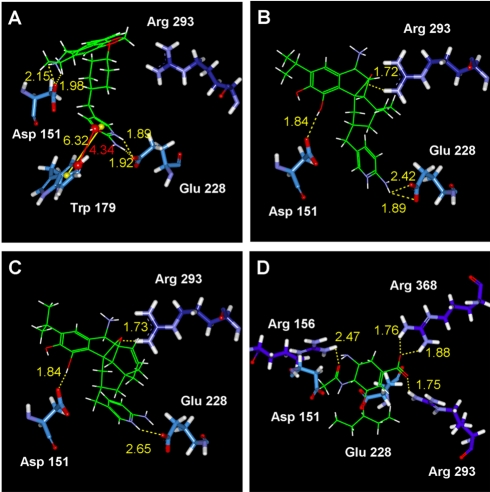
Docking pose of TCM candidates and Tamiflu® in N1.(A) Xylopine_2, (B) Rosmaricine_14, (C) Rosmaricine_15 and (D) Tamiflu®.